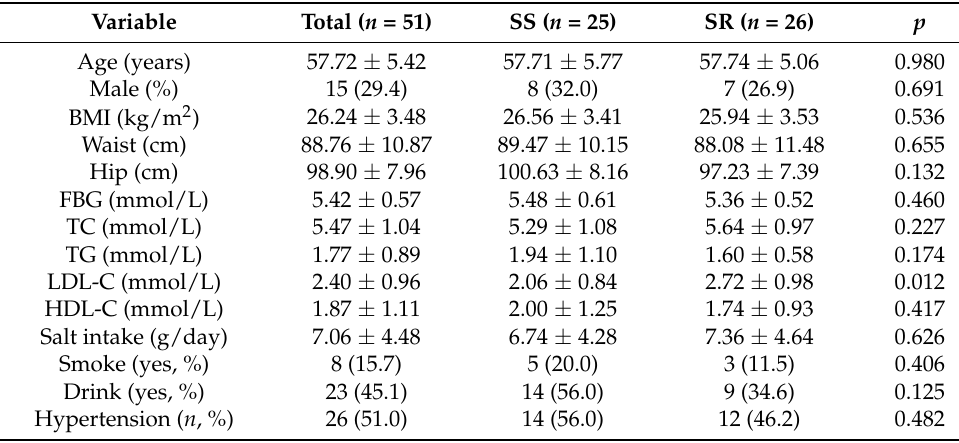
Table 1. Basic characteristics of the subjects in this study ( n =